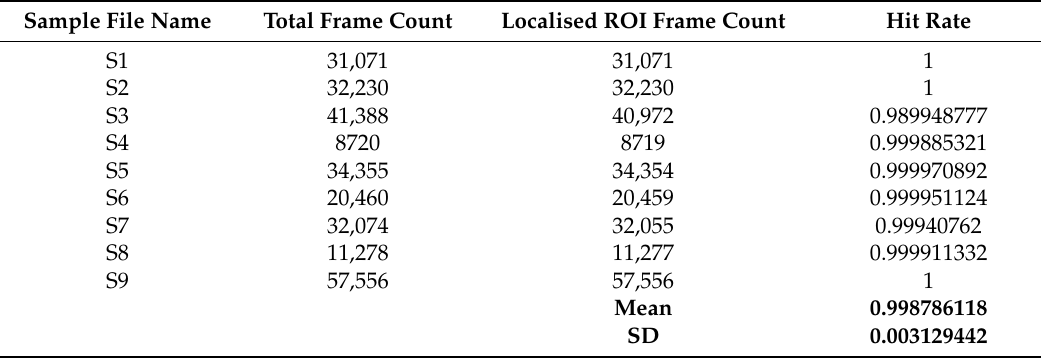
Table 4. Frames count in the tested video samples and the eye localisation method hit rate.